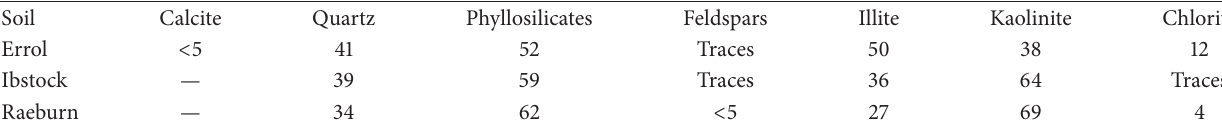
Table 3: Mass percentages of each mineral and clay